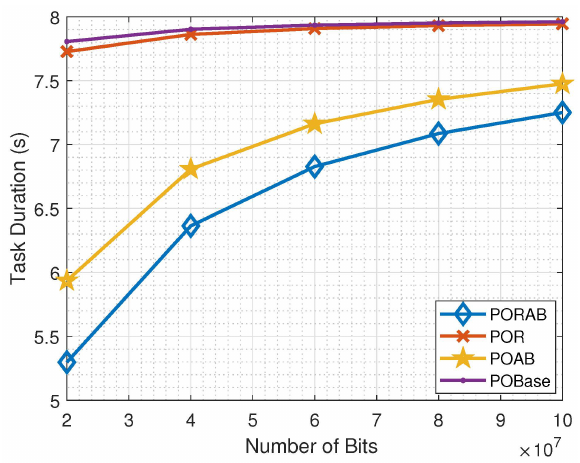
Figure 7. Variation of task computation time with the volume of tasks in terms of bits.